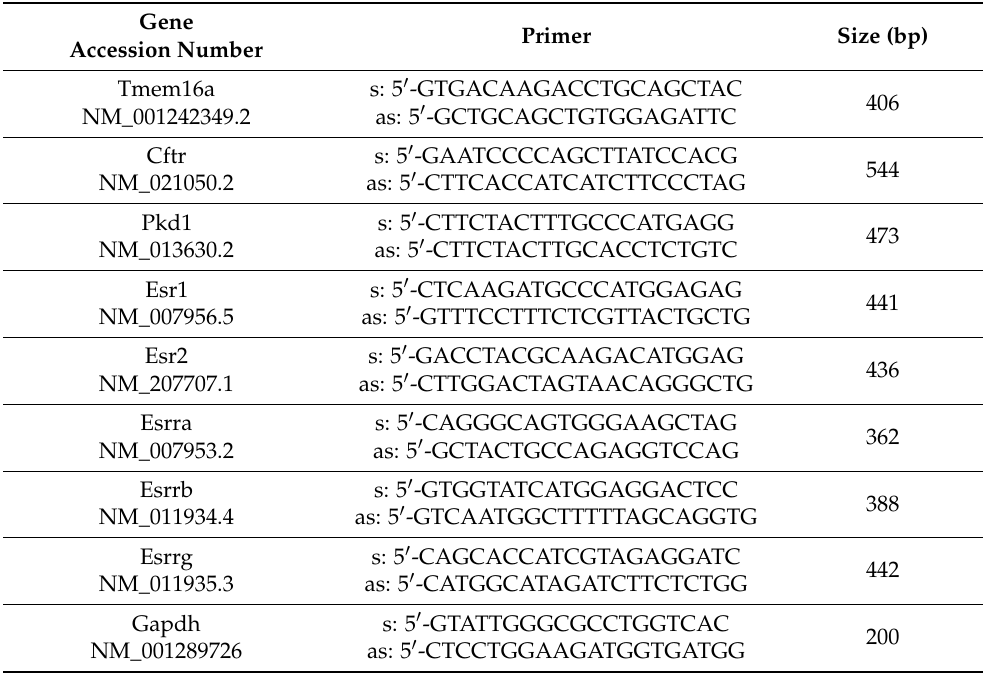
Table 1. Primers used for